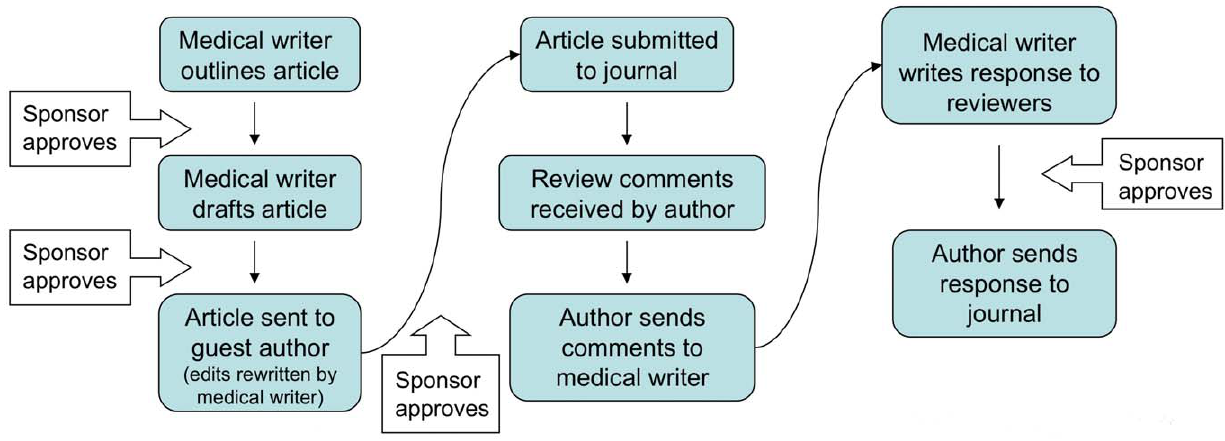
Figure 1. Acknowledging ghostwriters does not accurately reflect their authorship role. Modified from [14]. Used under a Creative Commons license which permits the modification and re-use of intellectual content as long as it is properly acknowledged.